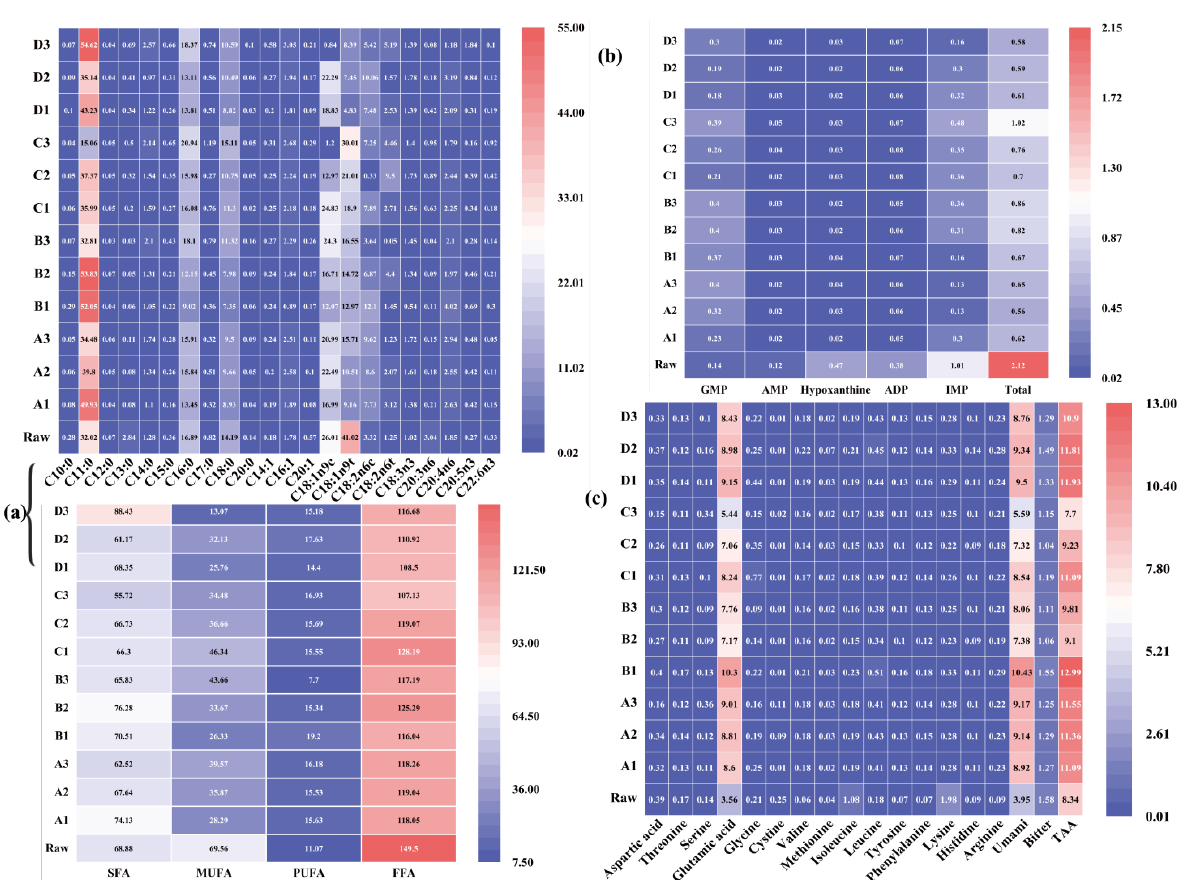
Figure 4. ( a ) Heat map visualization and clustering results of the fatty acid in beef samples (FFA: total free fatty acids; PUFA: polyunsaturated fatty acid; MUFA: monounsaturated fatty acid; SFA: saturated fatty acid); ( b ) heat map visualization and clustering results of the nucleotides in beef samples; ( c ) heat map visualization and clustering results of the free amino acids in beef samples. (Umami: sum of aspartic and glutamic acid. Bitter: sum of histidine, arginine, valine, methionine, phenylalanine, isoleucine, and leucine.)